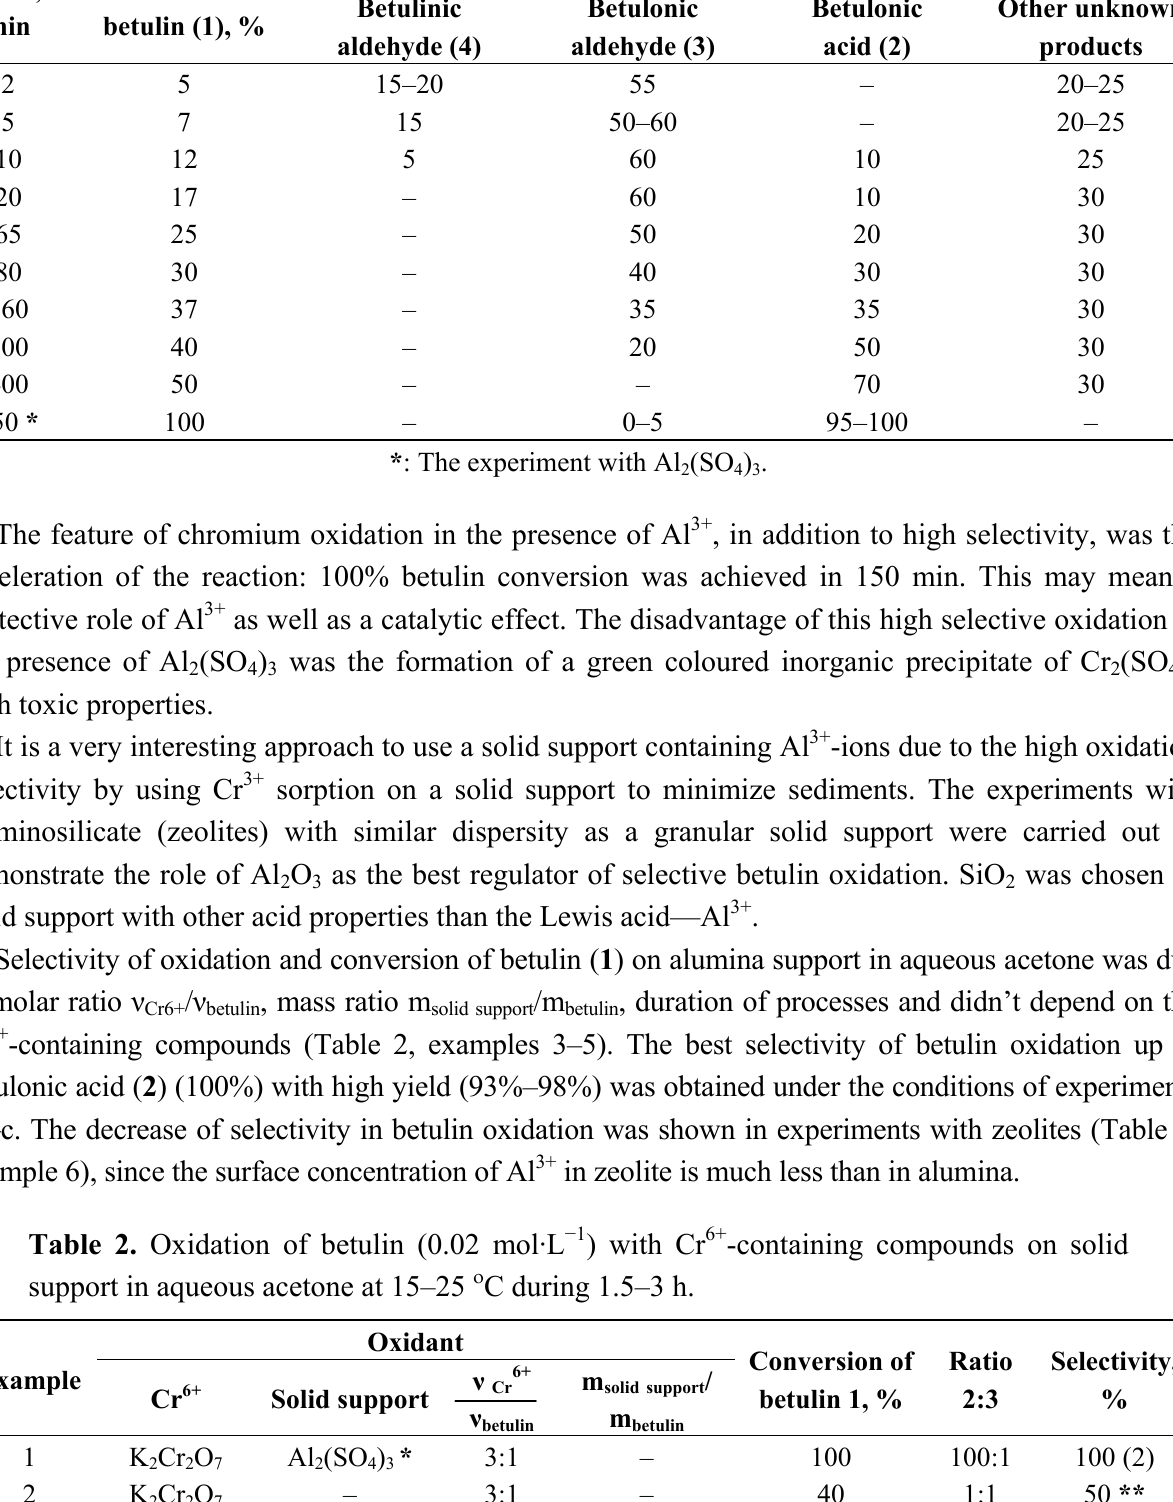
(SO ) at molar 2 4 3